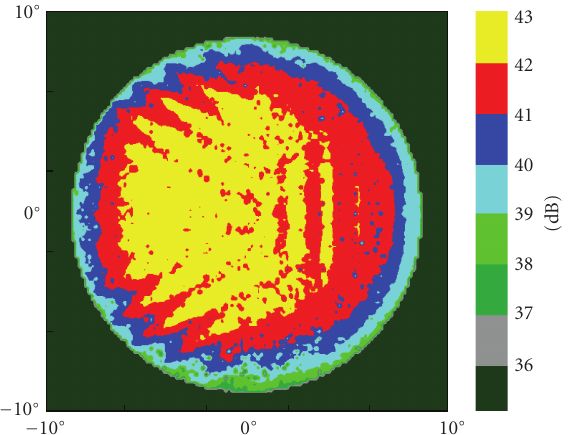
Figure 8: Minimum directivity of DBS beams, biased for gain, 7 colour, with errors, (scale 35 to 43 dBi).